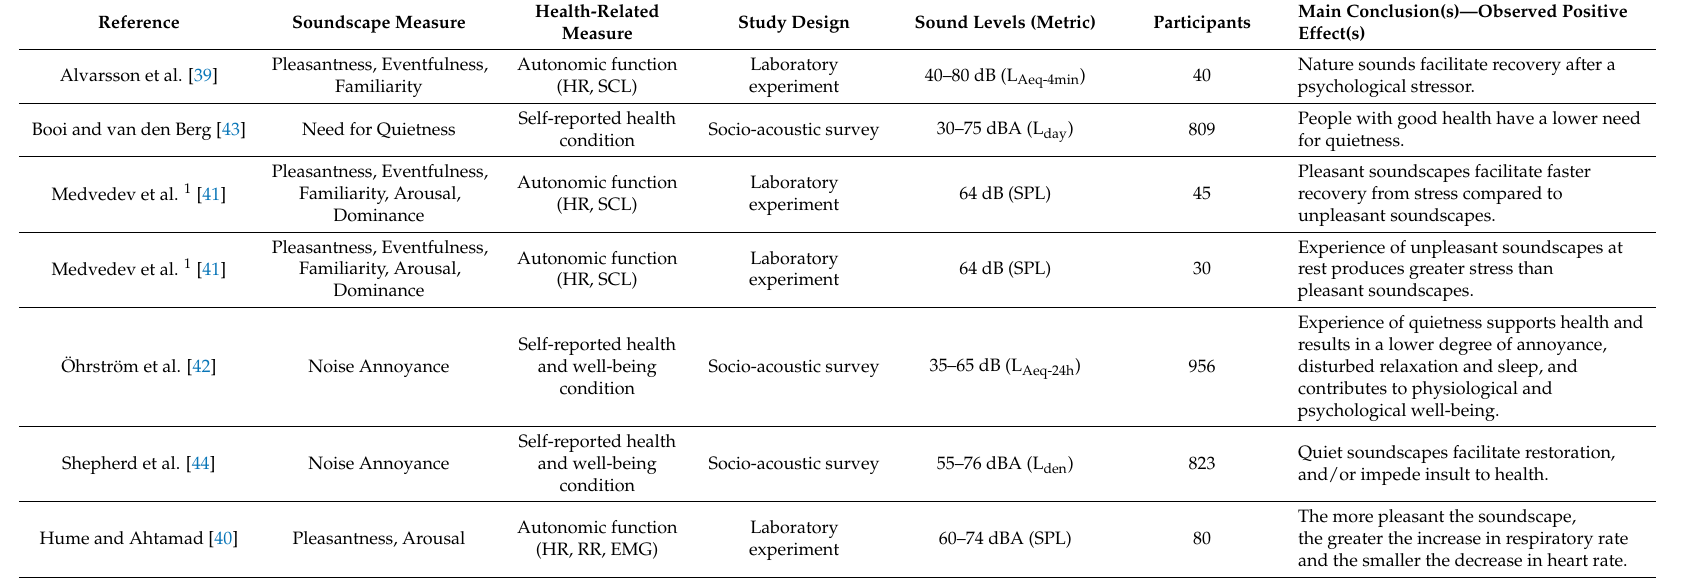
Table 1. List of studies included in the systematic review in chronological order of publication. The main soundscape and health-related measures, the study design, the sound levels, the number of participants and main conclusions of the studies are reported. Since the studies often included several experimental conditions and sound levels, these are reported as levels range (e.g., 40–80 dB, might include several experimental conditions of 40, 50 and 80 dB: For more specific information it is possible to refer to the original